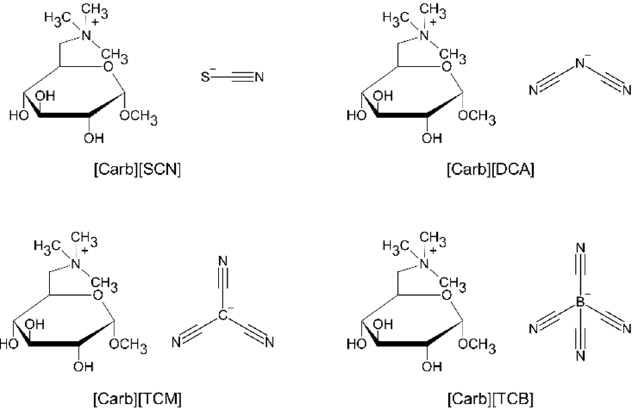
Figure 1. Molecular structures of the investigated carbohydrate-derived ionic liquids and salts with various cyano anions.